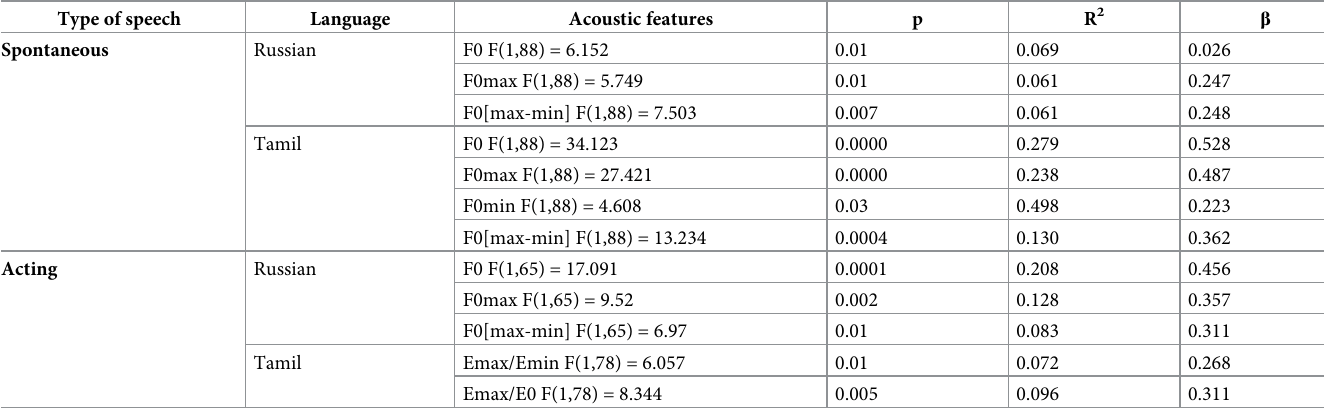
Table 2. Acoustic features of spontaneous speech and acting speech in the stimulus material predict emotional state (Regression analysis data). Type of speech